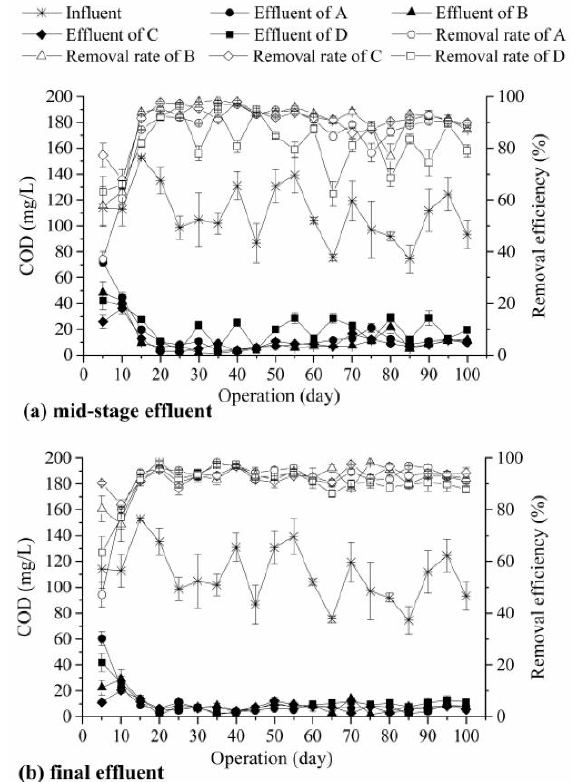
Figure 2. COD concentrations and removal efficiencies in different experimental MSL-SWI systems. ( a ): COD in mid-stage effluent; ( b ): COD in final effluent. After the start-up period, the COD concentrations of the mid-stage effluent in MSL- SWI A, B, C, and D were 9.79 ± 4.06 mg L − 1 , 7.69 ± 4.59 mg L − 1 , 8.03 ± 3.72 mg L − 1 ,